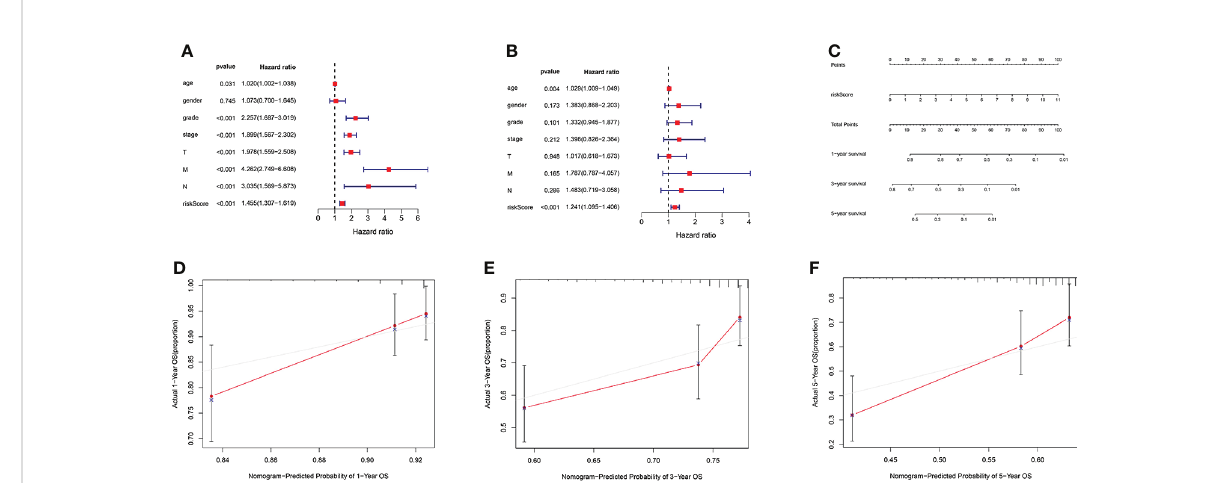
FIGURE 6 (A) Forest plot for univariate Cox regression analysis showing that grade, stage, T stage, M stage, N stage, and risk score were prognostic risk- related variables ( p < 0.001). (B) Forest plot for multivariate Cox regression analysis showing that only the risk score was the independent prognostic factor ( p < 0.001). (C) Nomogram integrating the risk score of four AAG-related lncRNAs. (D – F) Calibration curve analysis of the nomogram for predicting the 1-, 3-, and 5-year overall survival in The Cancer Genome Atlas